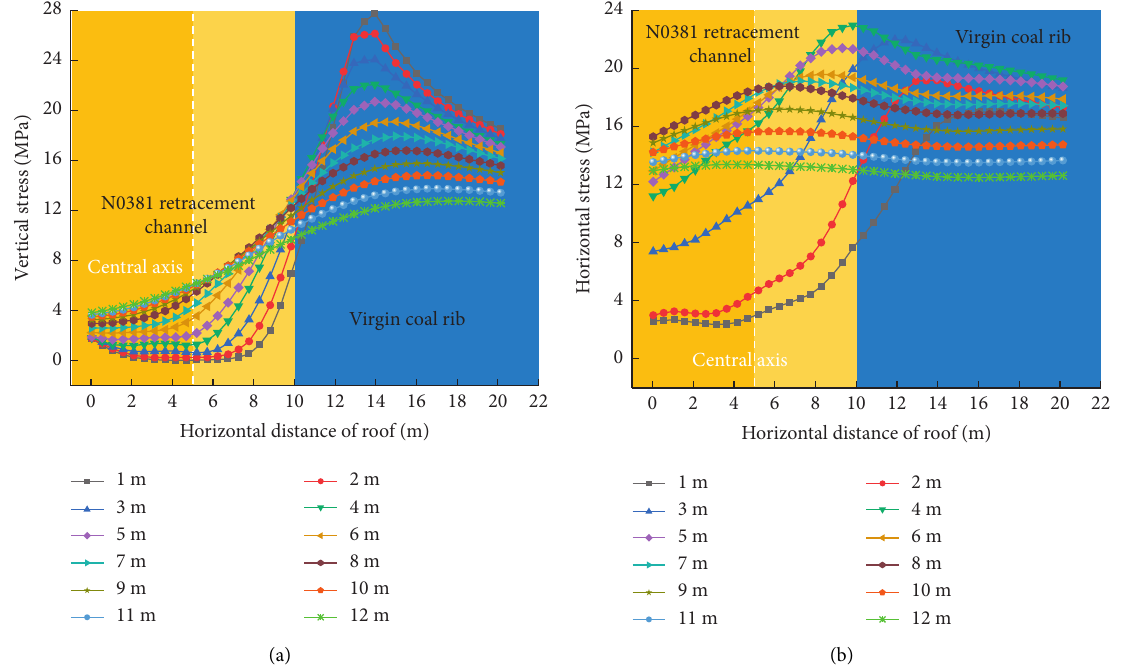
Figure 14: Stress distribution of the roof of N0381 retracement channel. (a) Vertical stress of different heights. (b) Horizontal stress of different